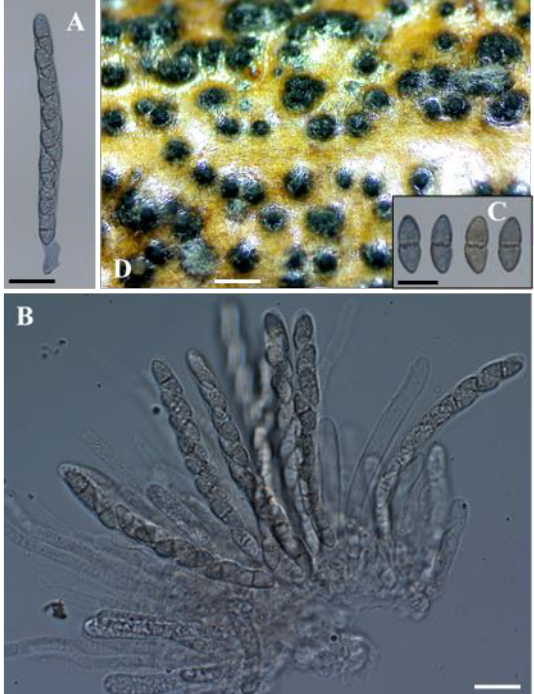
Figure 3. Seimatosporium cyprium isolate L111 (CBS 149019). ( A , B ) Cylindrical, 8-spored asci. ( C ) Fusiform, 2-celled ascospores. ( D ) Semi-immersed perithecia on autoclaved grapevine wood at 10 °C. Scale bars: 20 μm ( A – C ) and 500 μm ( D ).